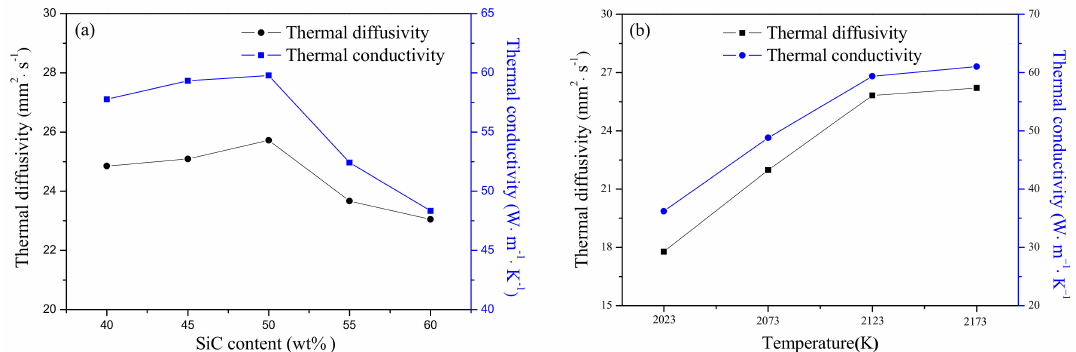
Figure 5. Thermal properties of SiC-AlN ceramics: ( a ) different SiC contents; ( b ) different sintering temperature.